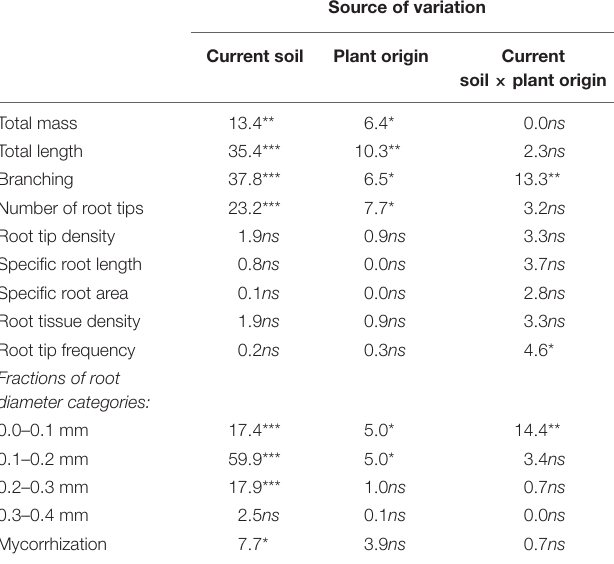
TABLE 4 | Two-way analysis of variance for different fine root traits of beech ( Fagus sylvatica L.) saplings, as measured in the second growing season of a rhizobox experiment; saplings originated from the sites Bad Brückenau (BBR) and Unterlüss (LUE) (factor “plant origin“) and were grown in material from the Bv horizon at BBR or from the Bh horizon at LUE (factor “current soil”); shown are F ( 1 , 14 ) values for the factors and their interactions; statistical significance is indicated as *** P < 0.001, ** P < 0.01, * P < 0.05; ns, not